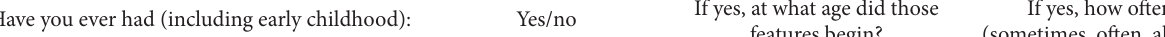
Table 3: SCN9A-associated features questionnaire. The responses of the patient described in this case report are shown. Have you ever had (including early